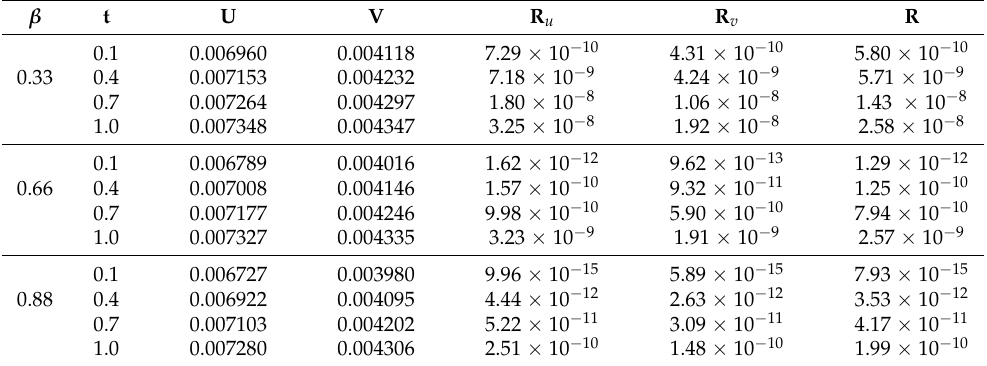
Table 2. LHPM solutions for different β in Example 1 when x = 7, α = 1.5, η = 0.5 and a = 0.7 (where R u , R v and R represents residual errors of U , V and system error, respectively).